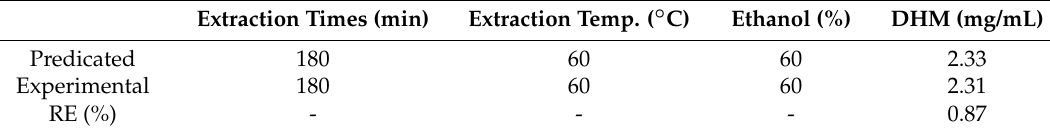
Table 4. The experimental validation of optimal extraction conditions of DHM from Chinese vine tea, Ampelopsis grossedentata , leaves as reported by this study. The predicted and actual yields of DHM obtained either through the developed BBD model or empirically through wet-extractions are shown. Extraction Times (min) Experimental RE (%)